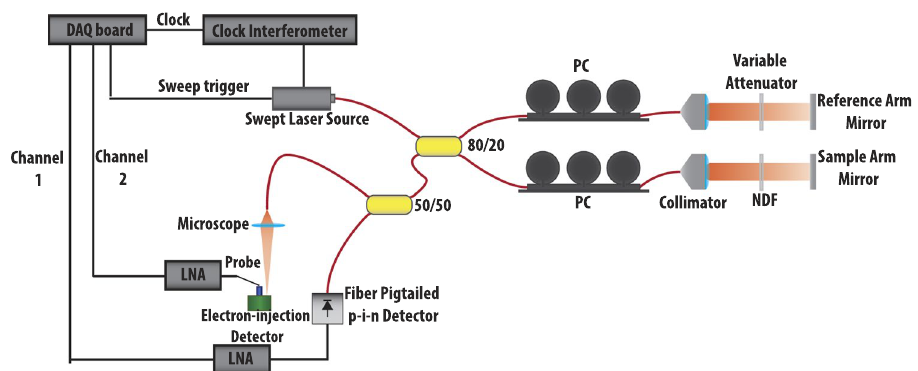
Figure 2. Schematic diagram of our SS-OCT measurement setup for comparing the electron-injection detector with the commercial p-i-n detector: Swept laser source has a central wavelength of 1060 nm, with 110 nm tuning range and 100 kHz scan rate. In order to be able to properly compare the SNR performance of our detector and a commercial fiber pigtailed p-i-n detector, a second directional coupler (50/50) was used to simultaneously send the interference signal to both detectors. Light was coupled to the electron-injection detector via a microscope set up, which added optical loss. NDF: Natural Density Filter, PC: Polarization Controller, LNA: Low Noise Amplifier, DAQ: data acquisition